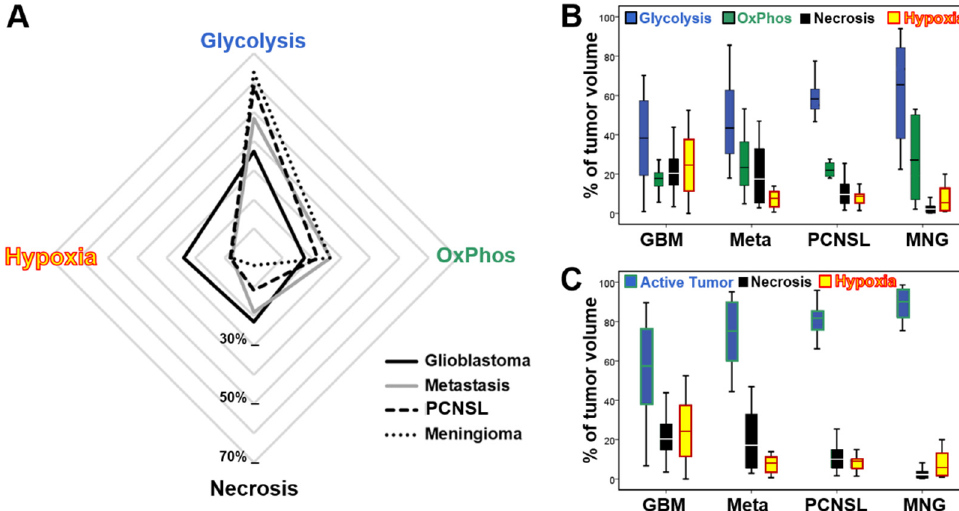
Figure 2. Comparison of the distribution of TME compartments in the different contrast-enhancing brain tumor entities. ( A ) Radar chart visualizing the distribution of the TME compartments with glycolysis, OxPhos, necrosis, and total hypoxia (sum of hypoxia with and without neovascularization) in the patient subgroups with glioblastoma (black line), brain metastasis (gray line), primary CNS lymphoma (PCNSL, dashed line), and meningioma (dotted line), respectively. ( B ) Box and whisker plots show the distribution of the TME compartments with glycolysis (blue), OxPhos (green), necrosis (black), and total hypoxia (yellow/red). ( C ) Box and whisker plots show the distribution of active tumor volume (i.e., the sum of glycolysis and OxPhos (blue/green), necrosis (black), and total hypoxia (yellow/red). Note: Boxes are mean ± SD, and whiskers are minimum and maximum values, respectively. Table 1. Distribution of the TME compartments for the four contrast-enhancing brain tumor entities.